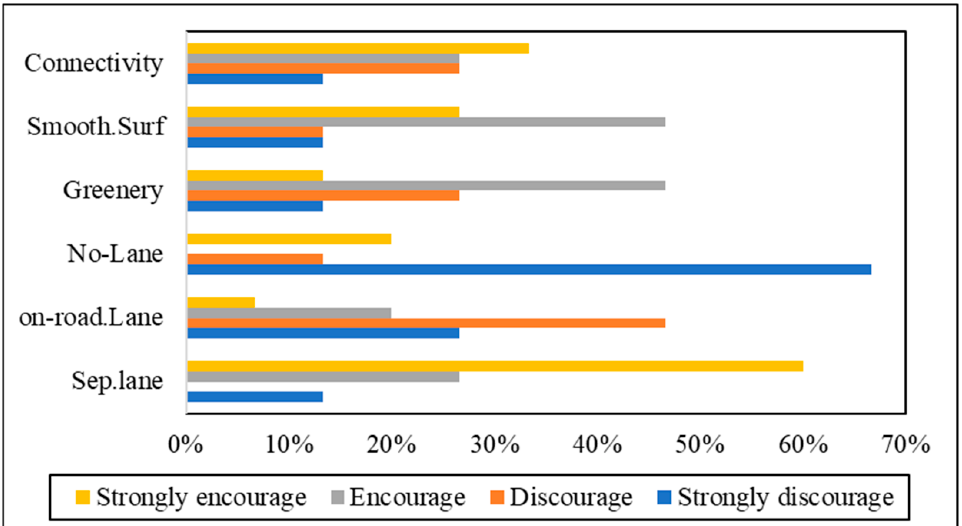
Figure 8. Impact of road features on the perceptions of respondents who believed safety was an extremely preventative factor for riding an e-scooter.